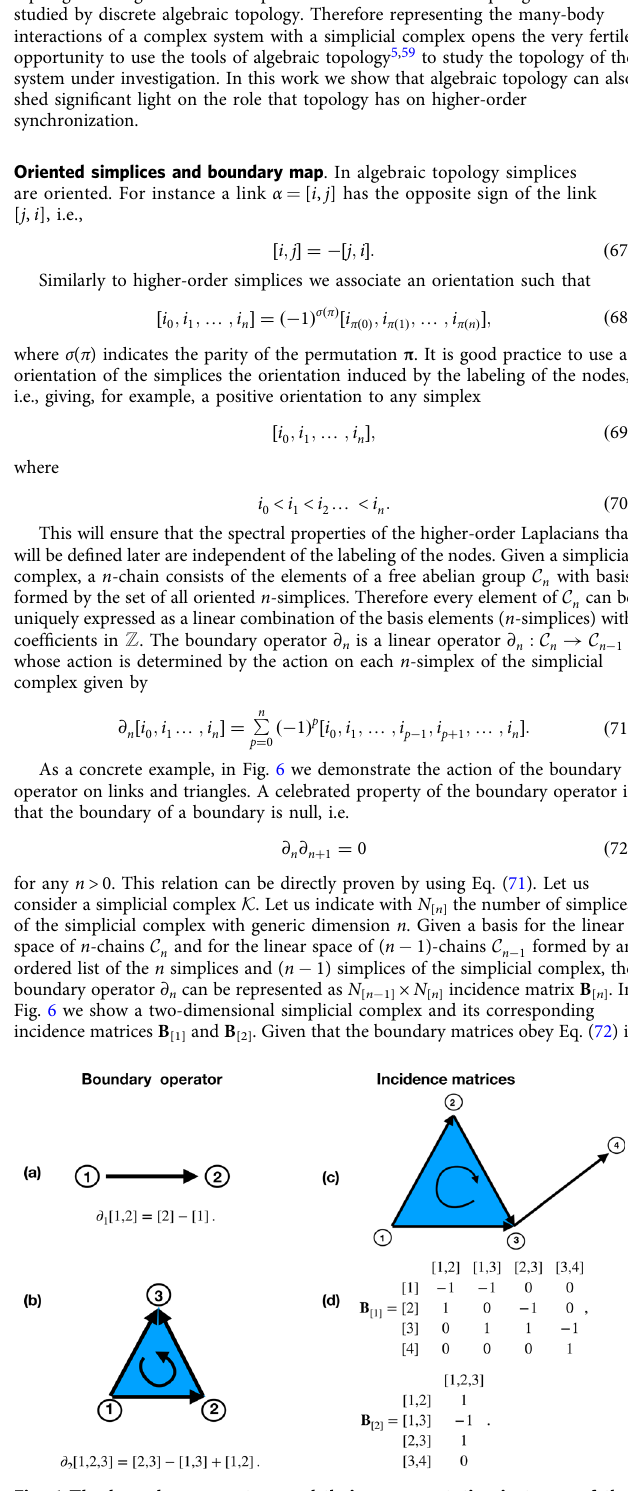
Fig. 6 The boundary operators and their representation in terms of the incidence matrices. Panels ( a ) and ( b ) describe the action of the boundary operator on an oriented link and on an oriented triangle respectively. Panel ( c ) shows a toy example of a simplicial complex and panel ( d ) indicates its incidence matrices B [1] and B [2] representing the boundary operators ∂ 1 and ∂ 2 ,